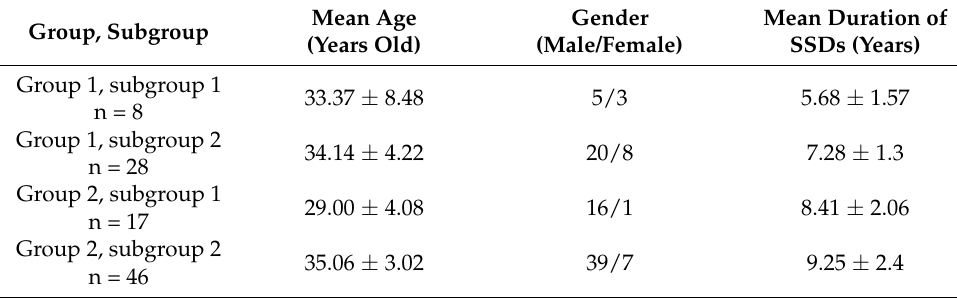
Table 3. Groups of patients with schizophrenia spectrum disorders.